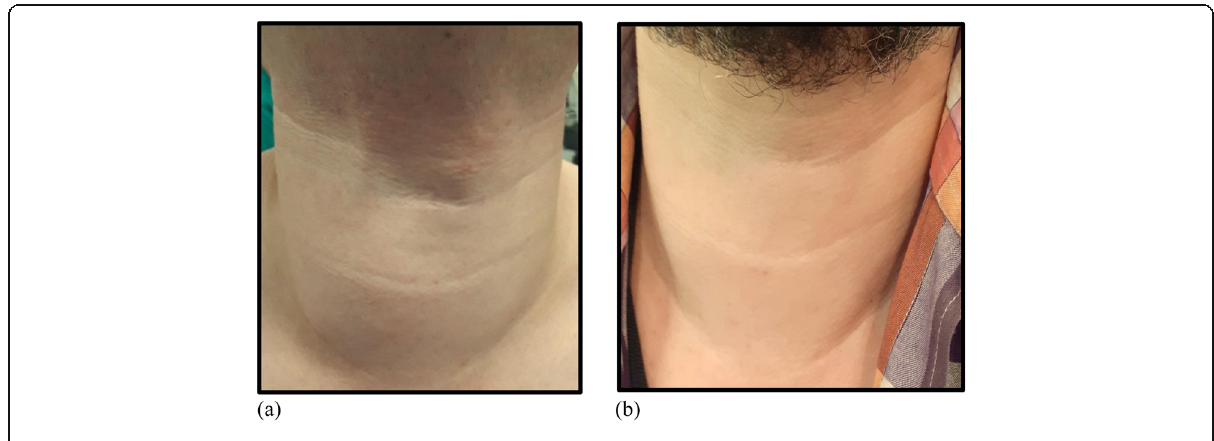
Fig. 12 A 42-year-old male patient had complained of neck bulging due to benign thyroid nodule. a Before RF ablation, he had severe neck bulging. b After RF ablation, neck bulging improved gradually during the follow-up period (6 months after RF